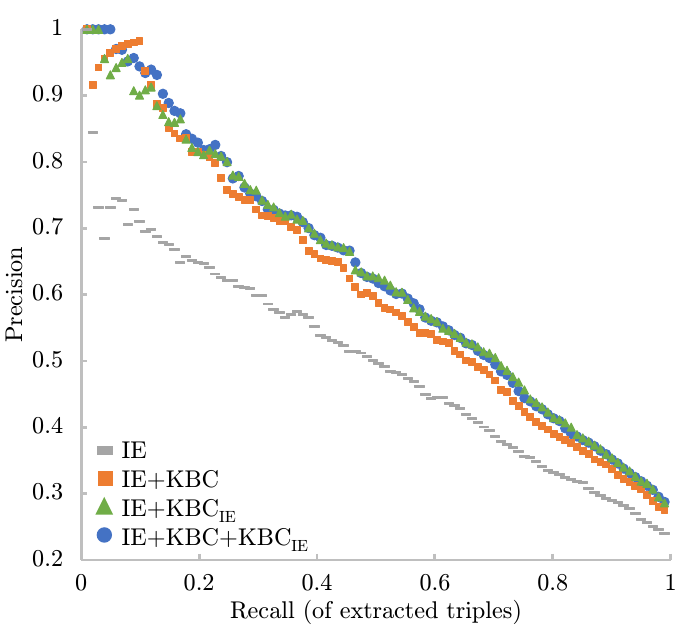
Figure 5. Precision recall curves for NYT-FB.